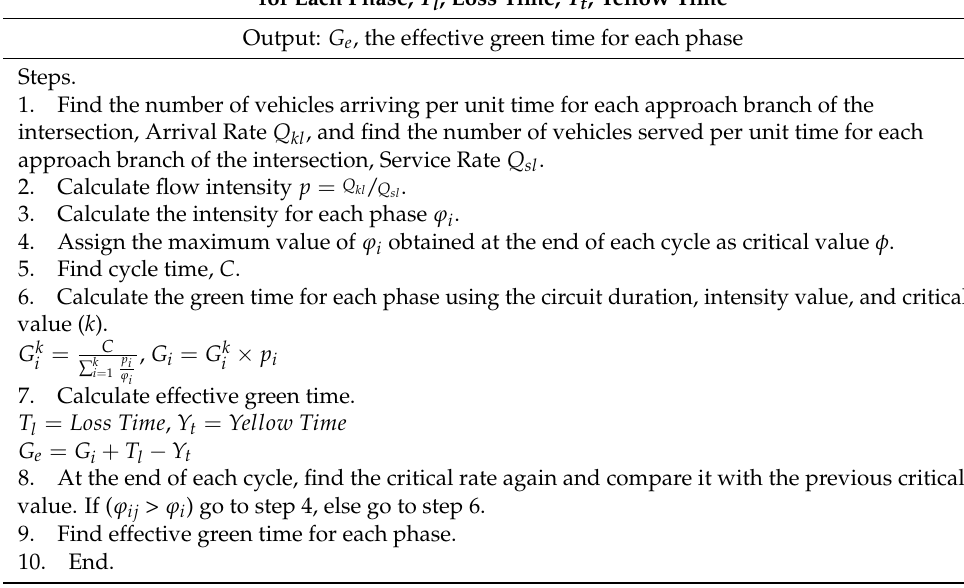
Table 5. Process steps for calculation of effective green